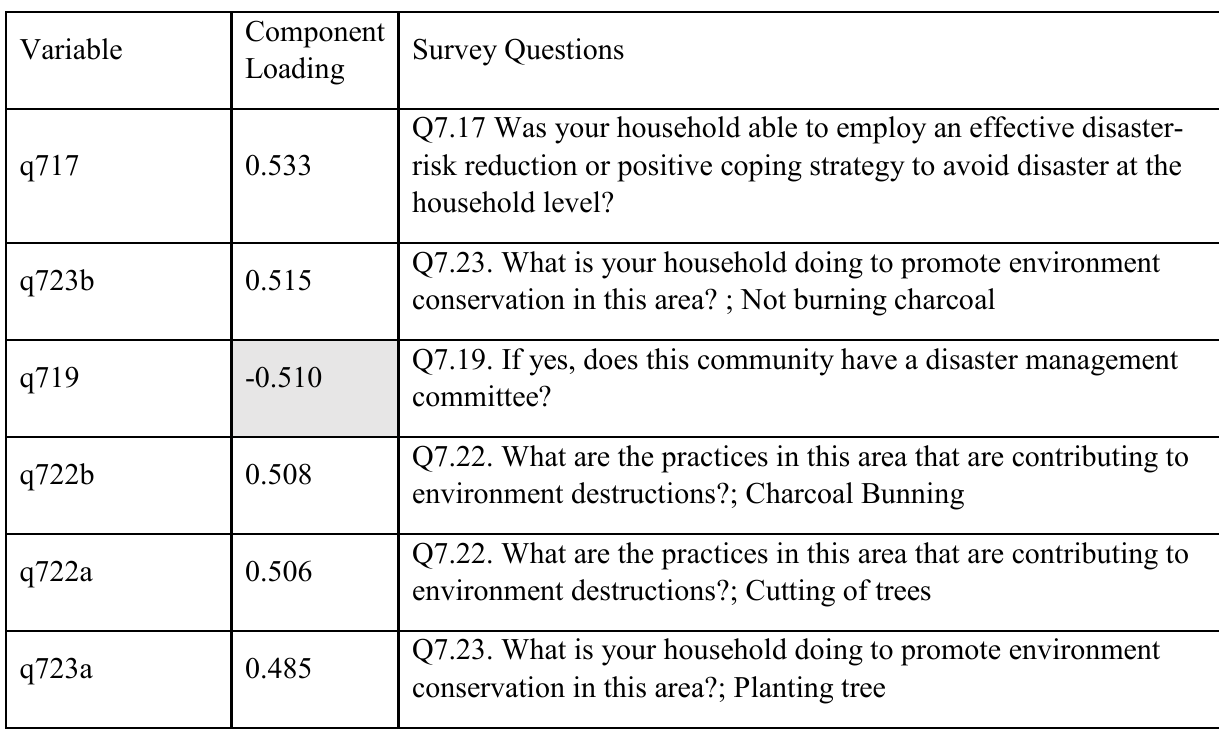
Table 1.26: Variables defining Adaptive Resilience